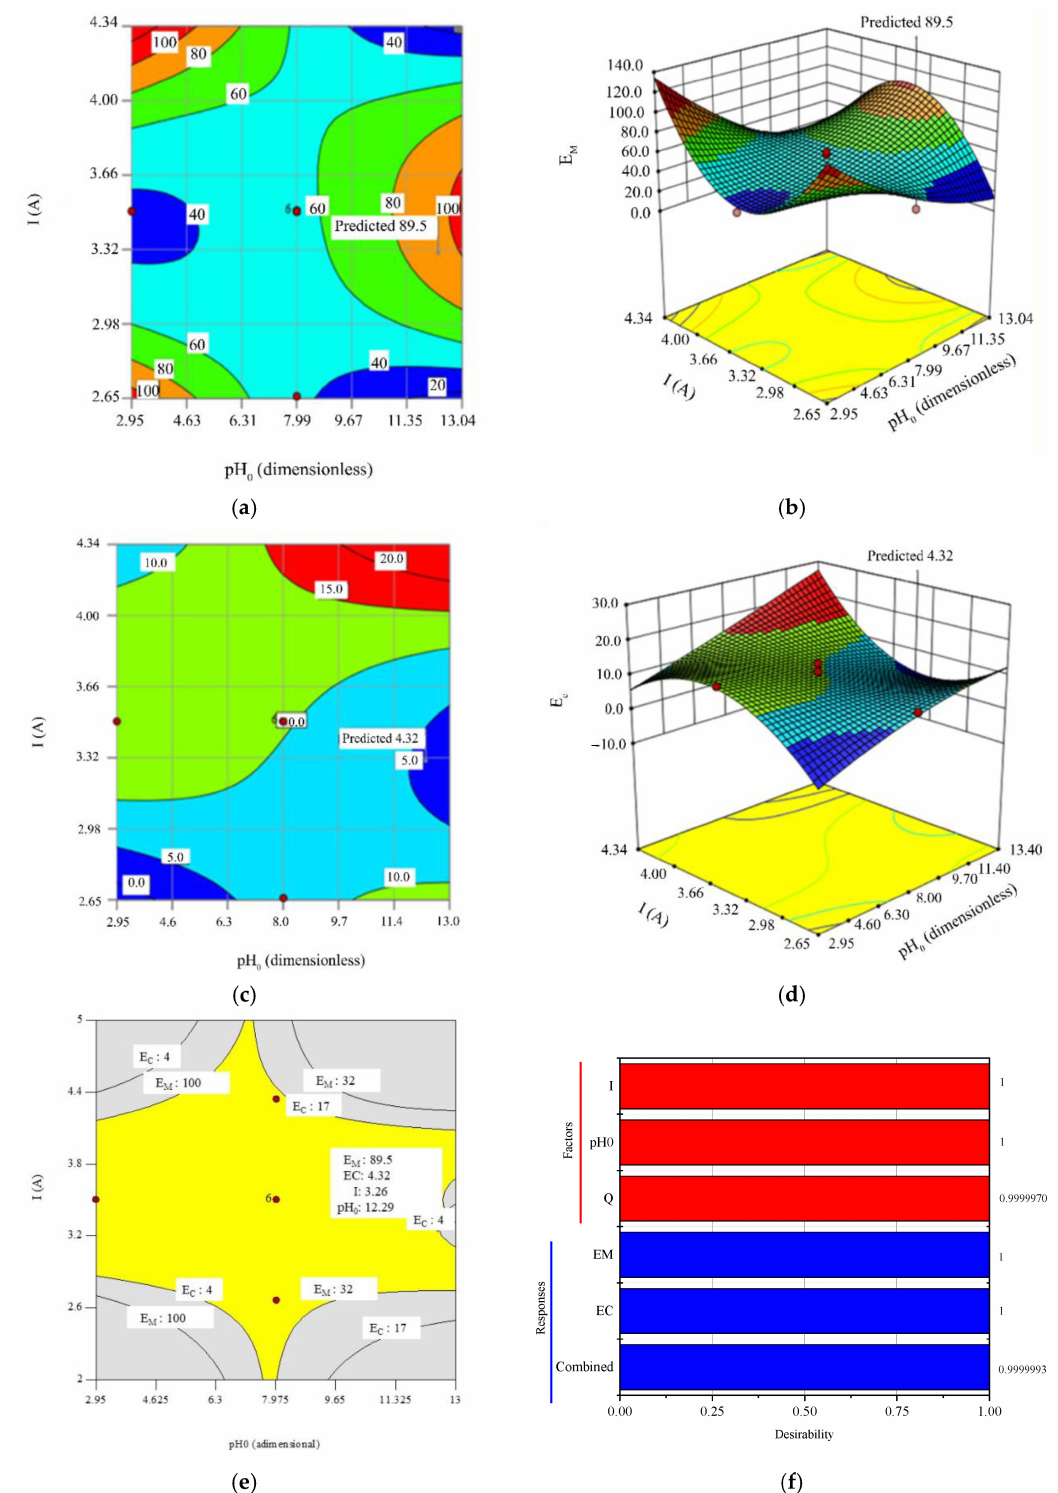
Figure 4. ( a ) Contour plot for response η 1 concerning pH 0 and I ; ( b ) 3D plot for response η 1 pH 0 and I ; ( c ) Contour plot for response η 2 concerning pH 0 and I ; ( d ) 3D plot for response η 2 pH 0 and I ; ( e ) Optimal region plot, pH 0 versus I ; ( f ) Bar chart of desirability. Plots ( a ) to ( b ) were edited at a volumetric flow rate of 1 L / min.